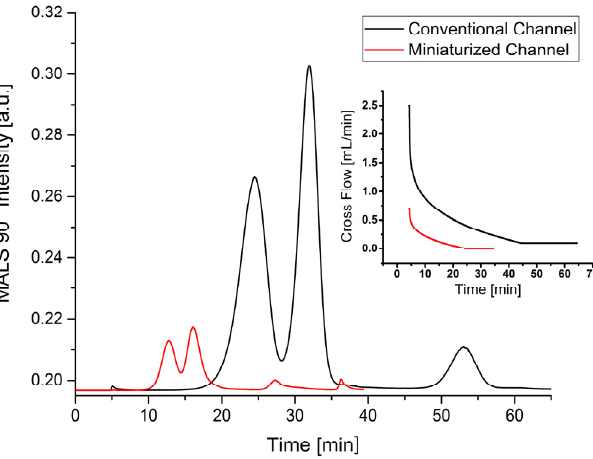
Figure 3. Comparison of fractograms of mixtures of polystyrene nanoparticles in a conventional (black line, mixture 3, Table 4) and a miniaturized AF4 channel (red line, mixture 7, Table 4, sample dilution 1:8) at previously optimized conditions. Insert shows cross flow profile, MALS 90° detector. Table 6. Comparison of chromatographic parameters of a polystyrene nanoparticle mixture obtained with both channels (single measurement).